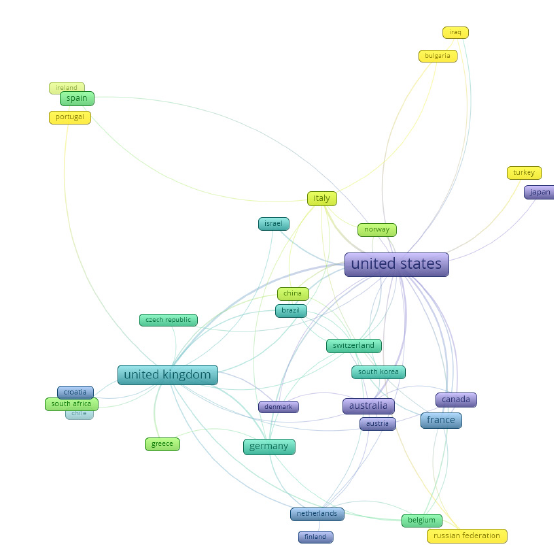
Figure 7. Spatial component of the bibliometric analysis of the concept of public debt